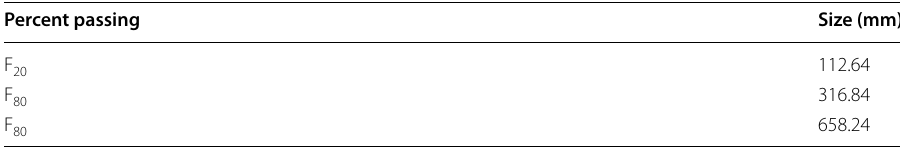
Table 3 Values of F20, F50, and F80 for the first